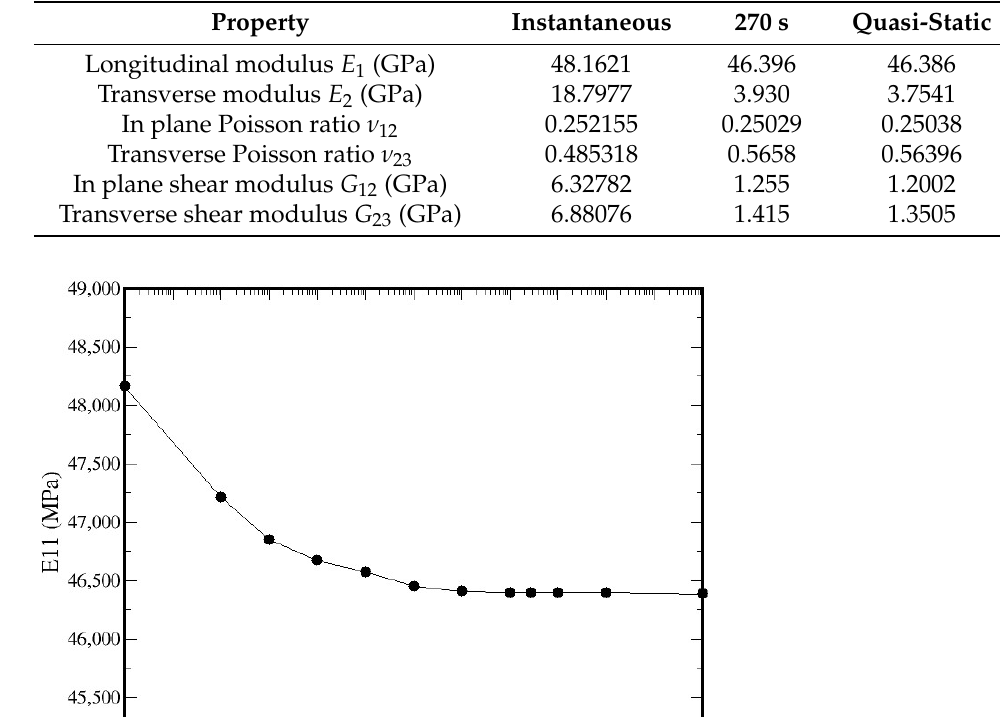
Table 1. Elastic Properties after elastic and viscoelastic Homogenization.